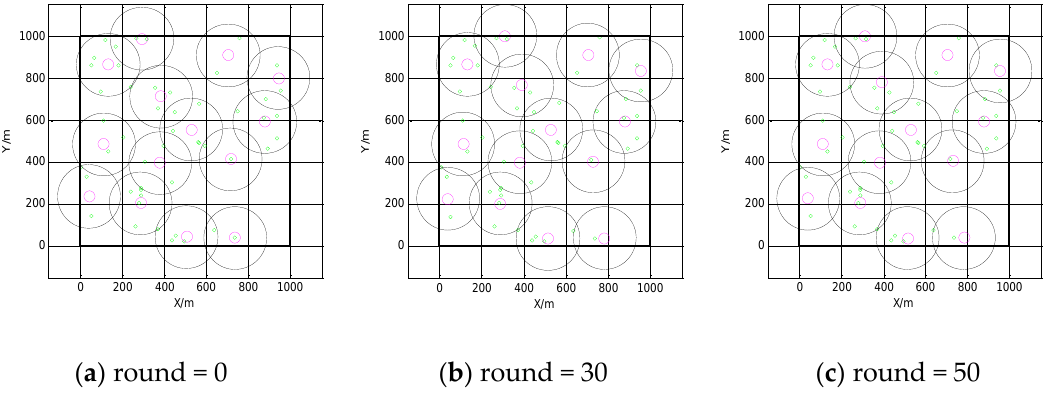
Figure 4. Location changing in different iteration with virtual force and motion.